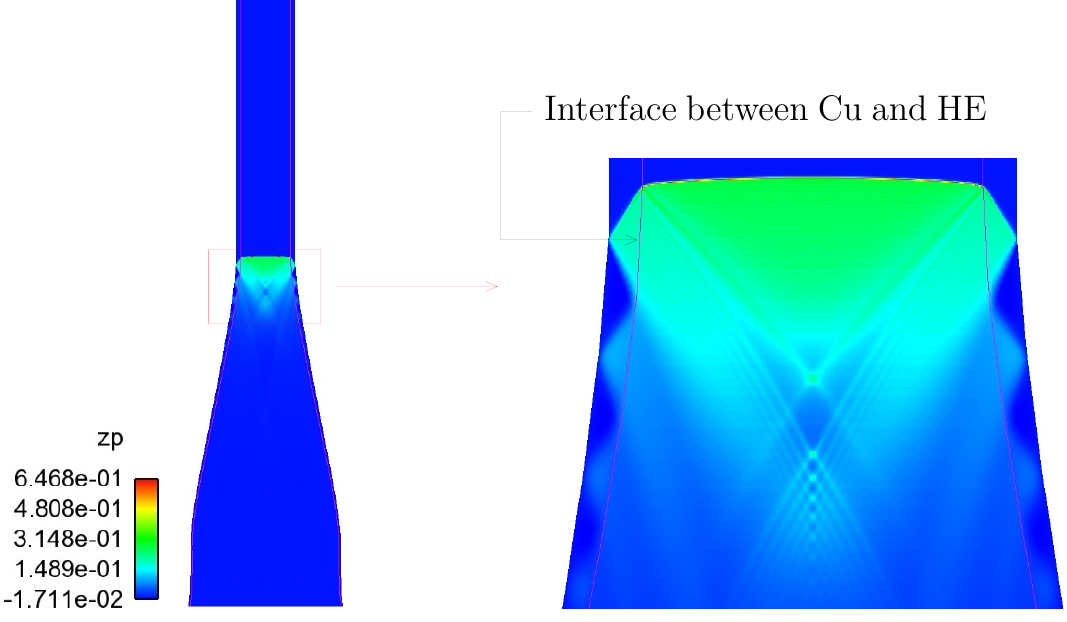
Figure 7. Detonation front at 20 µ